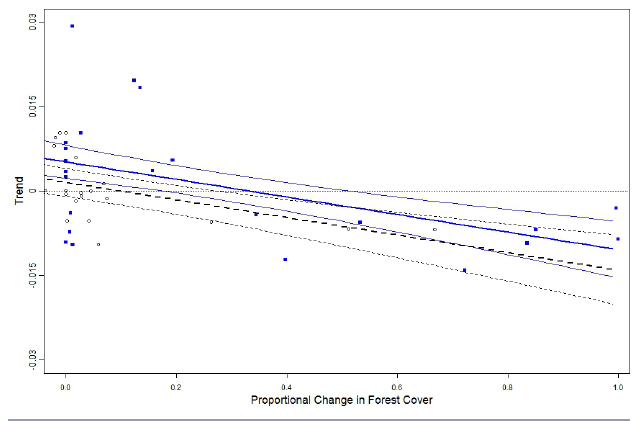
Fig. 5. Chipping Sparrow abundance decreased with greater proportional change in forest cover between circa 1994 and 2014 in old (blue squares and solid lines, with 85% confidence intervals [dashed lines]) vs. young or mature (open circles and black dotted lines, with 85% confidence intervals [dashed lines]) mixedwood stands. Percent annual change can be derived by multiplying the y-axis by